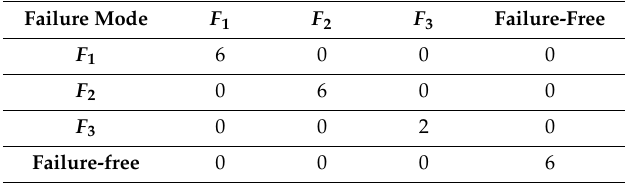
Table 5. Confusion matrix of the greenhouse’s classification